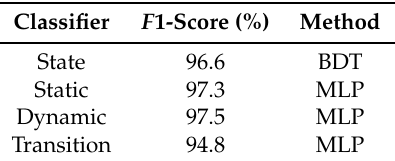
Figure 4. System workflow for processing raw IMU data and reporting via machine-learning-based activity classifiers, a rule-based model for test detection, and performance analyses. Table 2. F 1-scores of the classification methods for the different classifiers: Boosted Decision Trees (BDT) and Multilayer Perceptrons (MLP). Based on